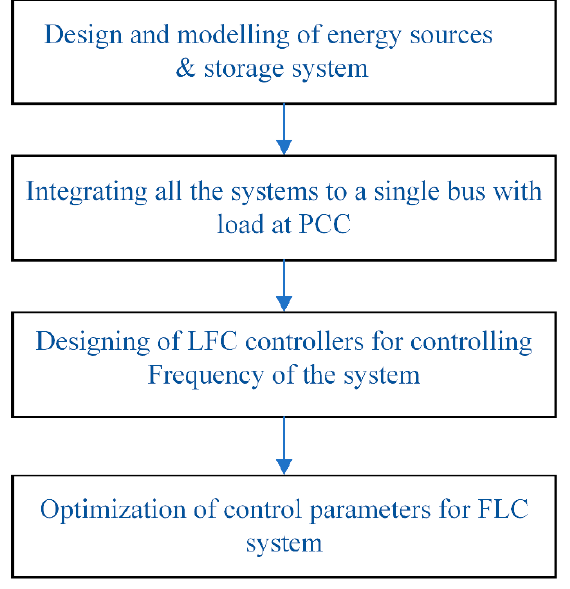
Figure 1. Work flow structure of present study.